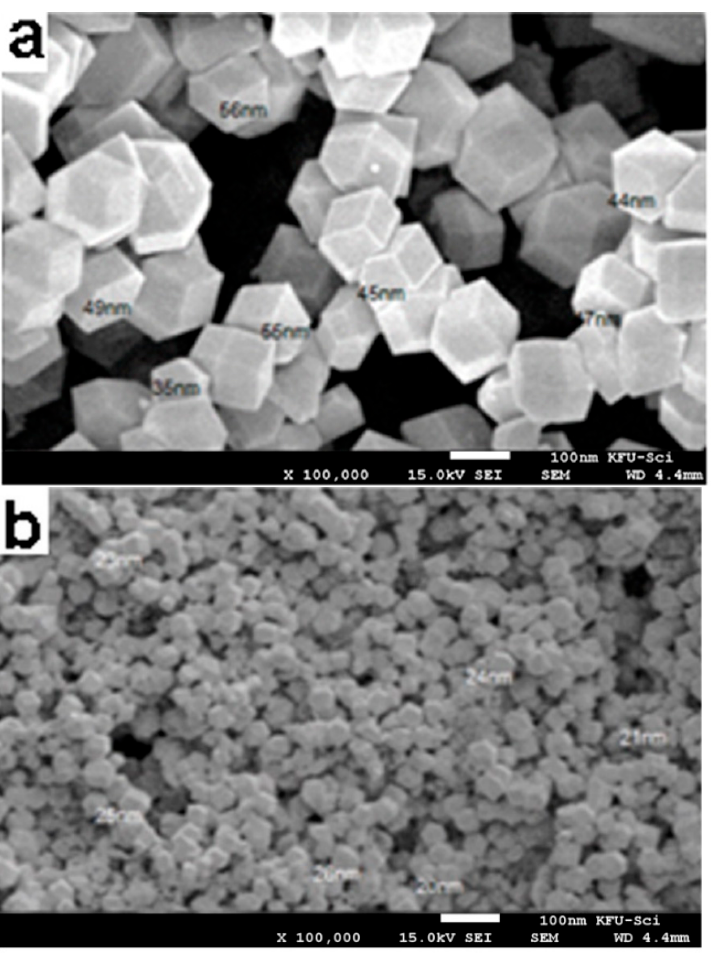
Figure 1. SEM images of ( a ) Zn-BTC and ( b ) Zn-BTC@CS.